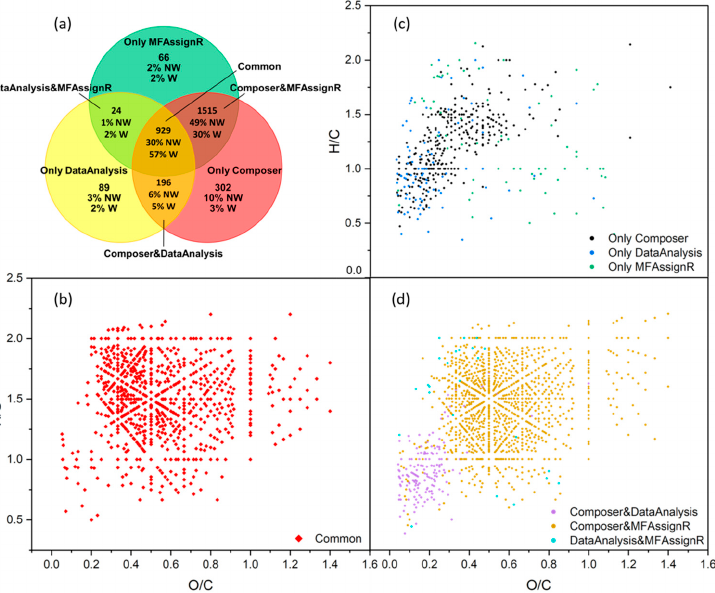
Figure 7. ( a ) Venn diagram comparing the number of MFs, the non-weighted (NW) and the weighted (W) percentages assigned by data treatment with Composer (red), MFAssignR (green), and DataAnalysis (yellow); ( b ) van Krevelen diagram of compounds belonging to “Common”; ( c ) van Krevelen diagram of compounds belonging to “Only Composer” (black), “Only DataAnalysis” (blue), and “Only MFAssignR” (green); ( d ) van Krevelen diagram of compounds belonging to “Composer&DataAnalysis” (violet), “Composer&MFAssignR” (ochre), and “DataAnalysis&MFAssignR” (turquoise).